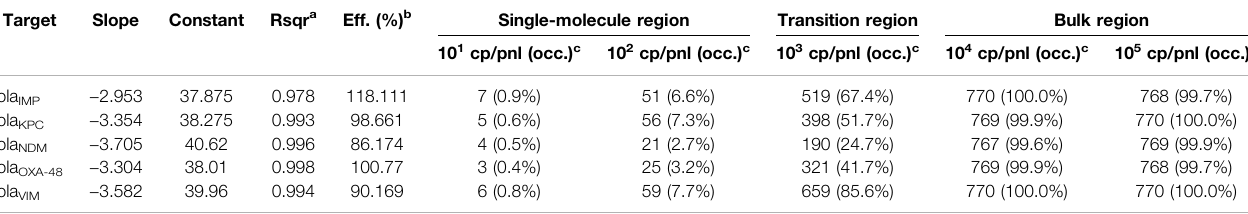
TABLE 2 | Standard curve parameter in real-time digital